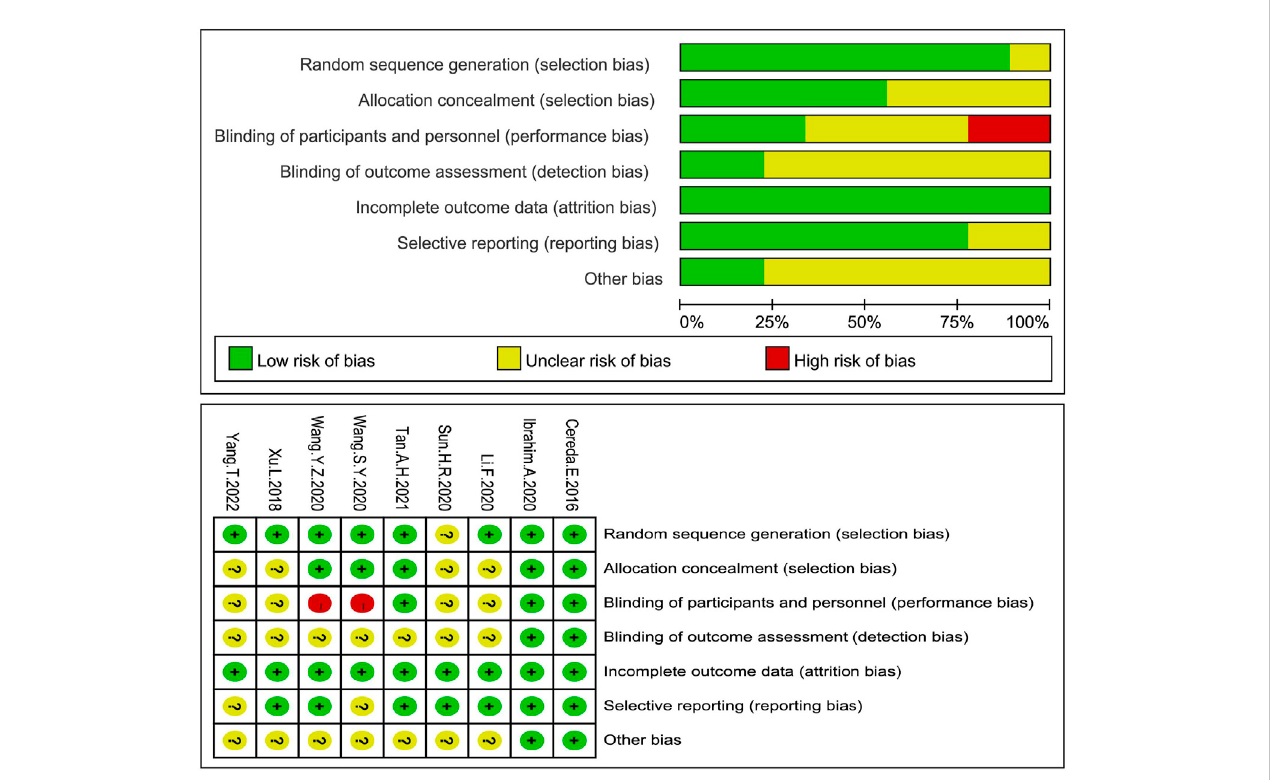
FIGURE 2 Evaluation of the risk of bias biases in all RCTs. RCTs in all groups were at the risk of biases, a low risk of biases (+), a high risk of biases (-) or an unknown risk of biases